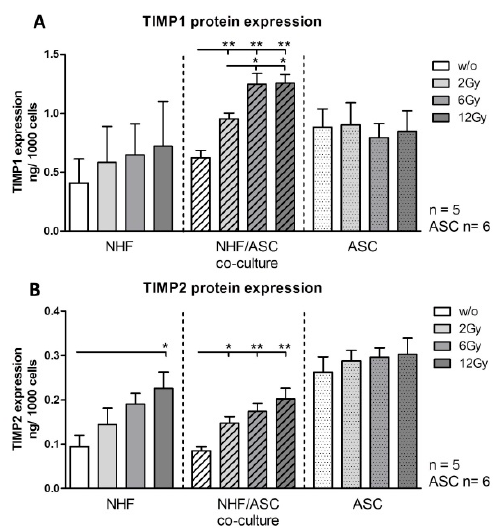
Figure 3. Protein expression of TIMP1 ( A ) and TIMP2 ( B ) in cell culture supernatants of NHF, ASC and co-cultured NHF/ASC 48 h after irradiation with 2–12 Gy compared to unirradiated ( w / o ) controls as determined by enzyme-linked immunosorbent assay (ELISA). Error bars represent standard error of the mean. NHF, co-cultures n = 5; ASC n = 6. * p < 0.05, ** p < 0.01.